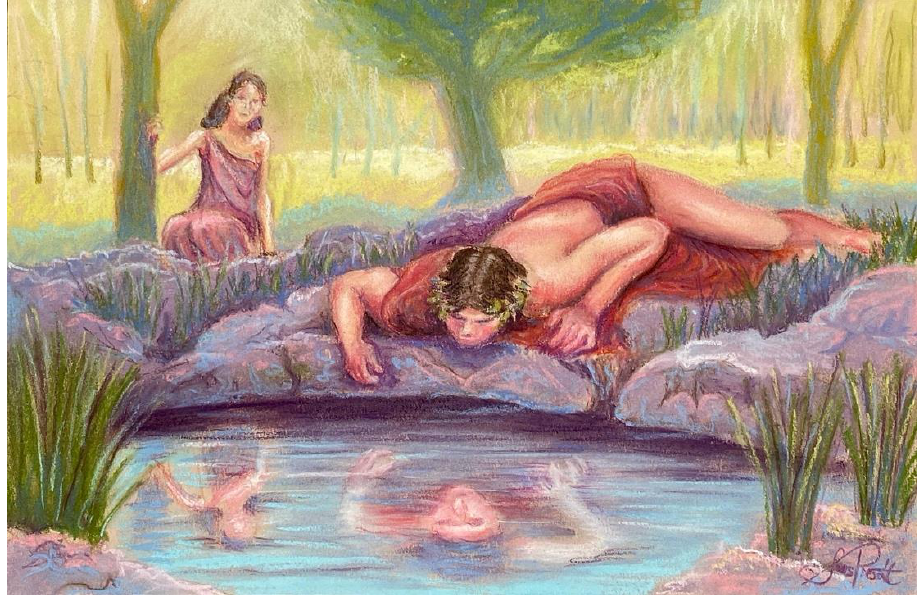
Figure 1. The legend of Narissus has served as a warning that superficial self-obsession ultimately leads to self-destruction, with neglect of deeper inner dimensions of meaningful self-awareness (artwork by author, S.L.P).